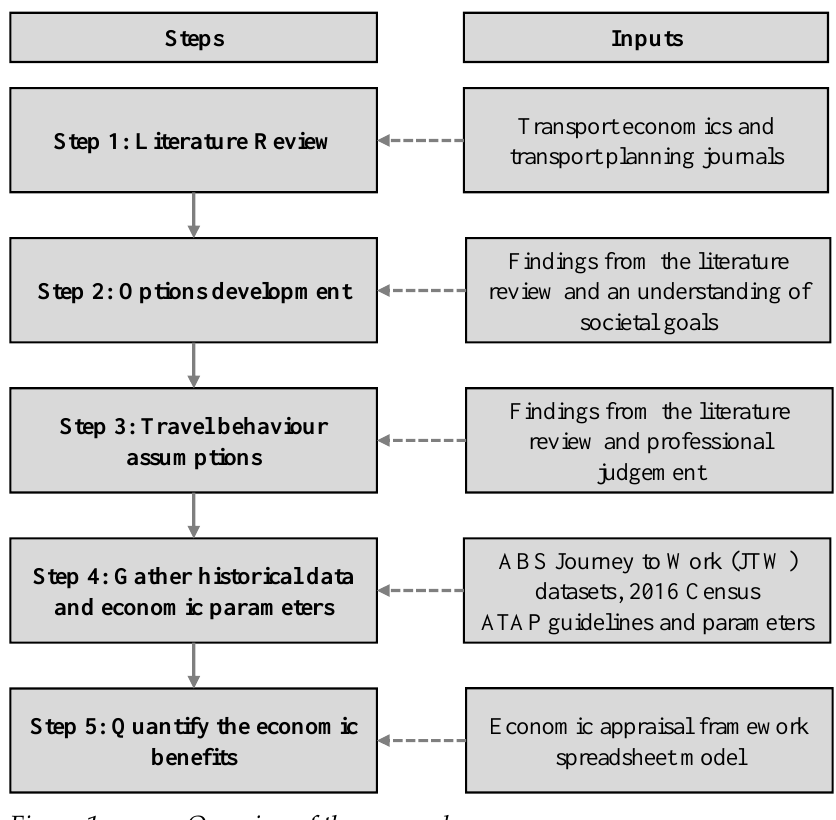
Figure 1. Overview of the